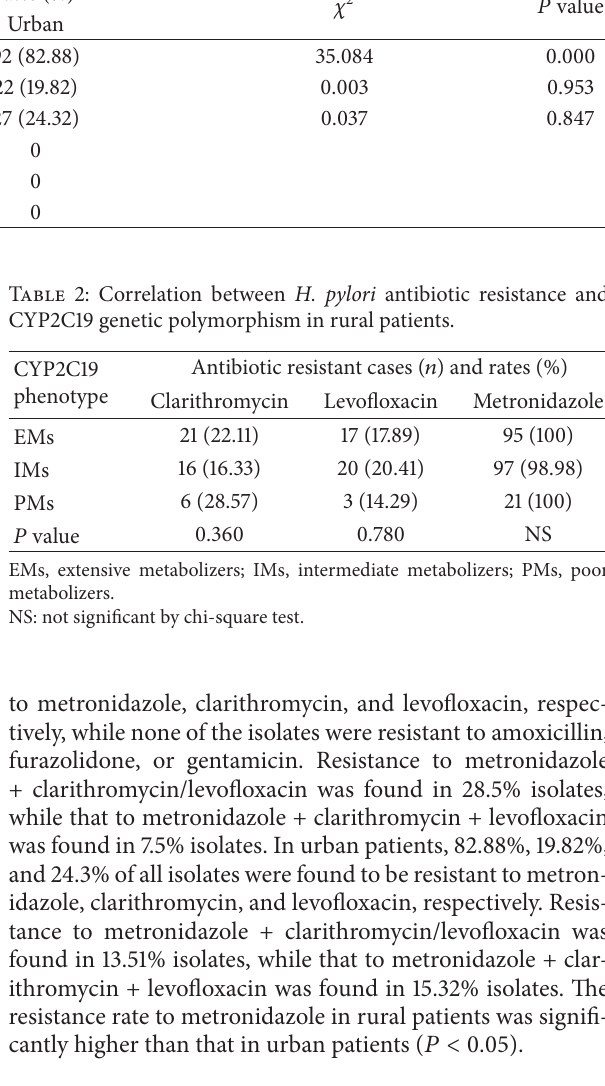
Table 1: Results of drug susceptibility tests of H. pylori among the rural and urban population in Chongqing. Antibiotic resistant cases ( 𝑛 ) and rates (%) 𝜒 2 Antibiotics